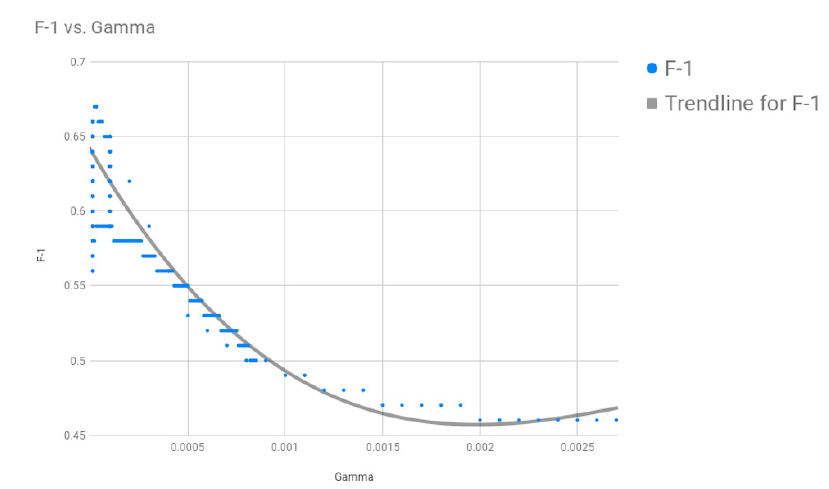
Figure 3. Graph of the cost parameter C vs. the F1-measure.